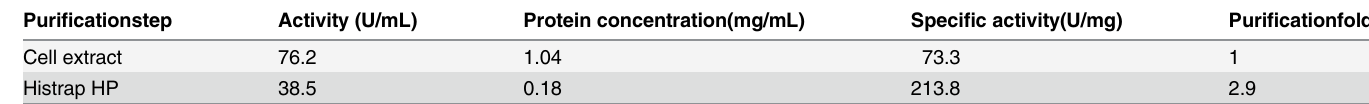
Table 4. Specific activities of the opt- nox in the process of purification.